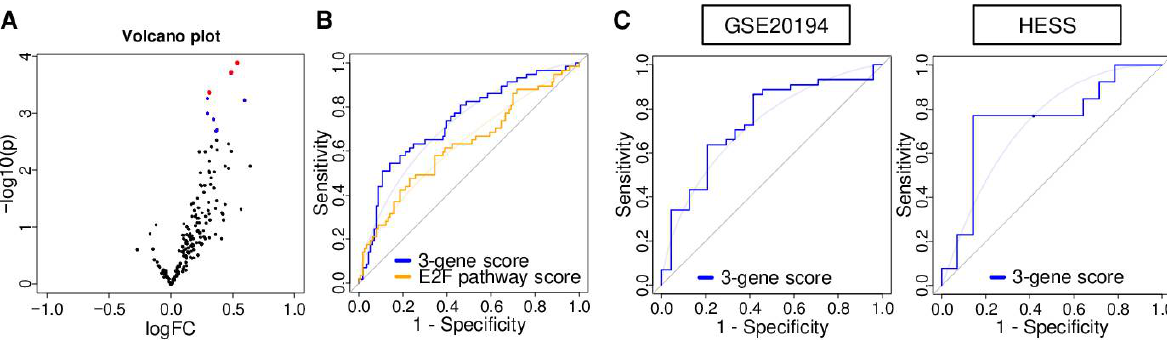
Figure 1. Establishment and association of the 3-gene score with response to neoadjuvant chemotherapy (NAC) for triple- negative breast cancer (TNBC). ( A ) Volcano plots illustrating the differentially expressed mRNAs between pathological complete response (pCR) ( n = 57) and non pCR groups ( n = 113) of TNBC in the GSE25066 cohort. X -axes; log 2 (fold change), Y -axes; −log 10 p -value from limma analysis. mRNA with adjusted p -value < 0.05 are marked in blue, and top three genes of p -value are marked in red. ( B ) Receiver operating characteristic (ROC) curve of the 3-gene score and E2F targets score with the area under the curve (AUC) in the GSE25066 cohort. ( C ) ROC curve of the 3-gene score with AUC in the GSE20194 and HESS cohorts.